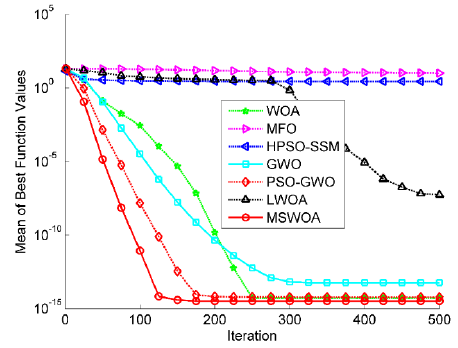
Figure 8. Optimization results for F10 (Dim = 30).